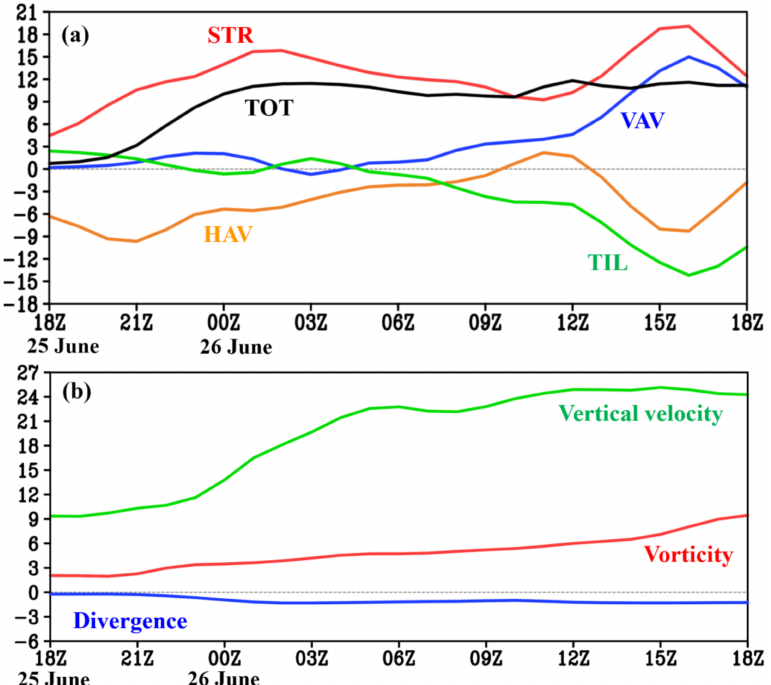
Figure 9. Panel ( a ) illustrates the key-region averaged vorticity budget terms (units: 10 − 10 s − 2 ) at 750 hPa. Panel ( b ) shows the key-region averaged vertical velocity (green line, units: 10 − 3 m s − 1 ), vorticity (red line, units: 10 − 5 s − 1 ) and divergence (blue line, units: 10 − 5 s − 1 ) at 750